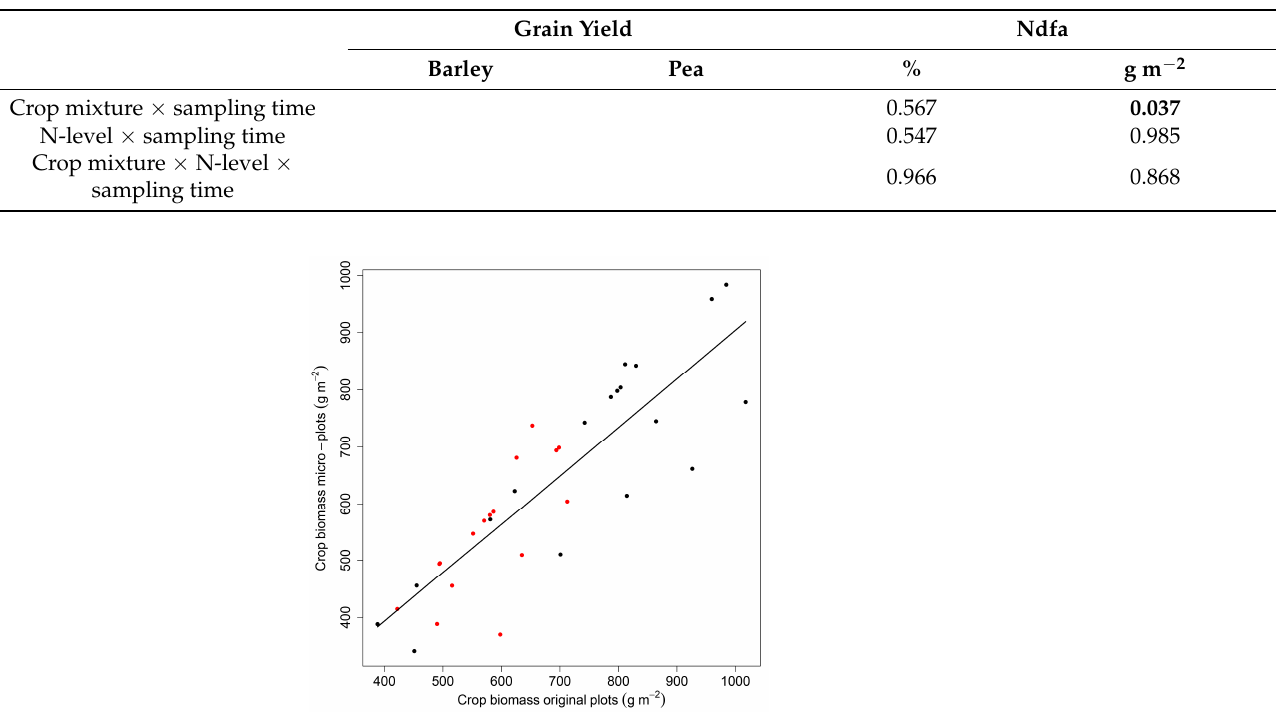
Figure A1. Relationship of crop biomass measured in the established micro-plots designated for 15 N-enrichment and natural abundance technique and crop biomass measured in the original plots where also the crop canopy parameters were measured. Marginal R 2 = 0.78. Red symbols: crop biomass at crop flowering, black symbols: crop biomass at crop maturity. Agronomy 2021 , 10 , x FOR PEER REVIEW